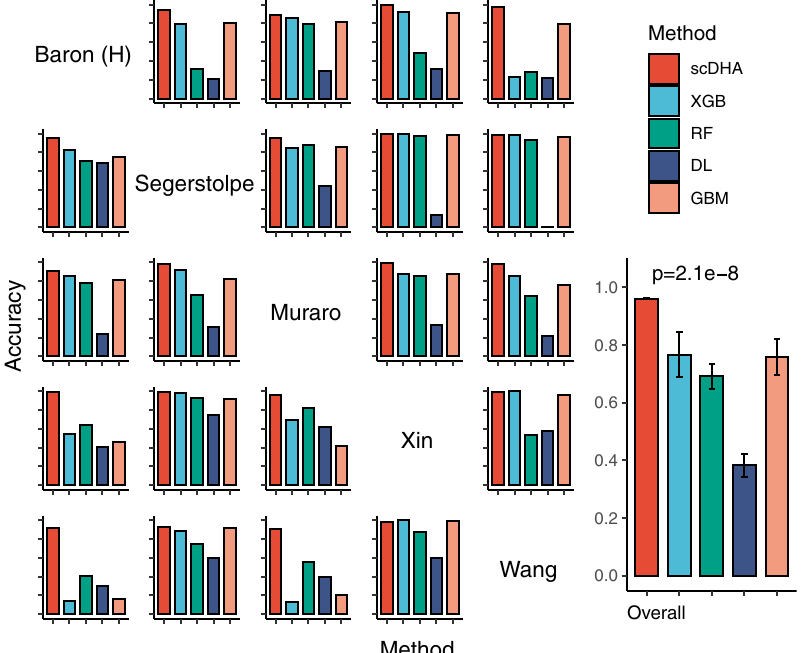
Fig. 2 Classi fi cation accuracy of scDHA, XGBoost (XGB), Random Forest (RF), Deep Learning (DL), Gradient Boosted Machine (GBM) using fi ve human pancreatic data sets. In each scenario (row), we use one data set as training and the rest as testing, resulting in 20 train-predict pairs. The overall panel shows the average accuracy values and their variance (vertical segment). The accuracy values of scDHA are signi fi cantly higher than those of other methods ( p = 2.1 × 10 − 8 using Wilcoxon one-tailed